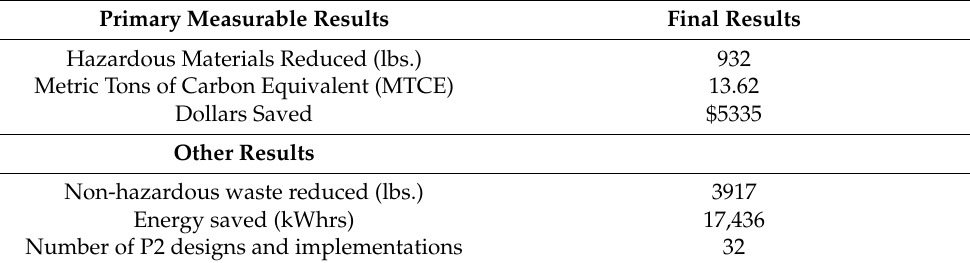
Table 3. Final public health and environmental reductions on a per year